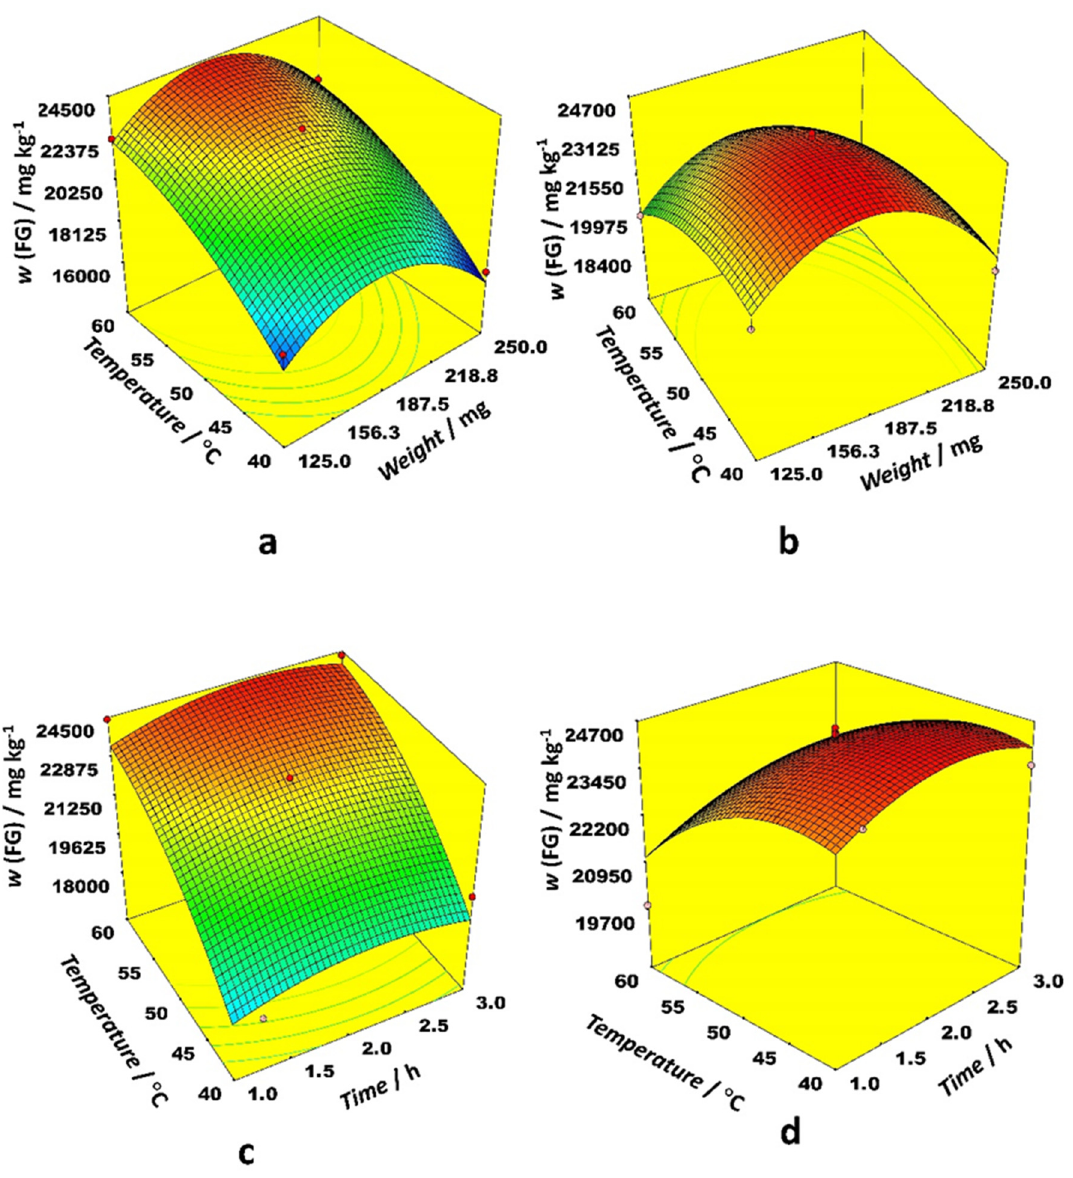
Figure 1. 3D response surface plots of the most prominent interaction factors for flavonol-glycosides extracted from grapevine leaves using ethanol (subfigures a , c ) and acetonitrile (subfigures b , d ) as organic modifiers.